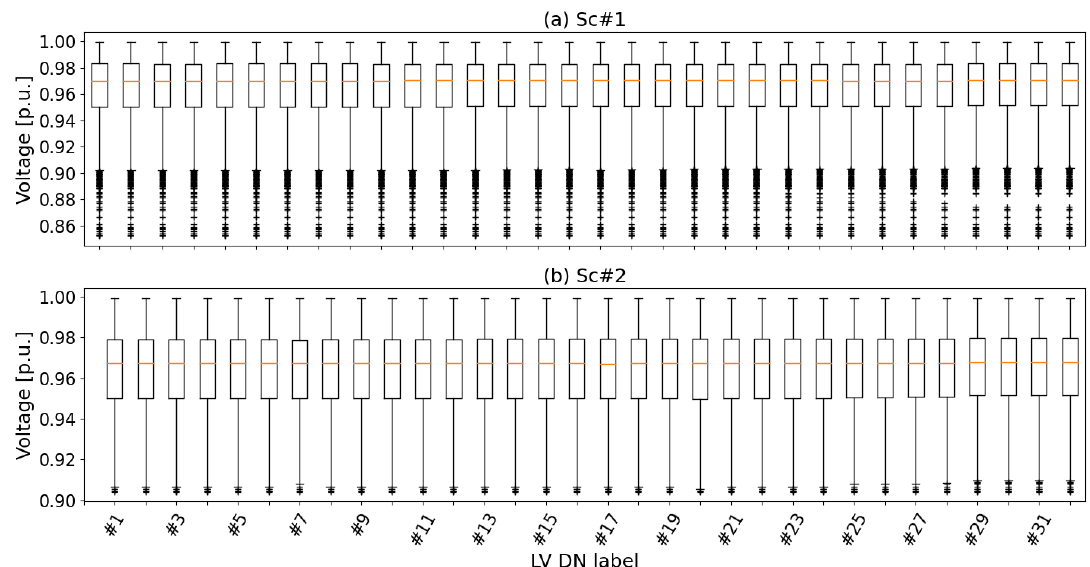
Figure 8. Boxplots of voltage values of all nodes within the examined time period for ( a ) Sc#1 and